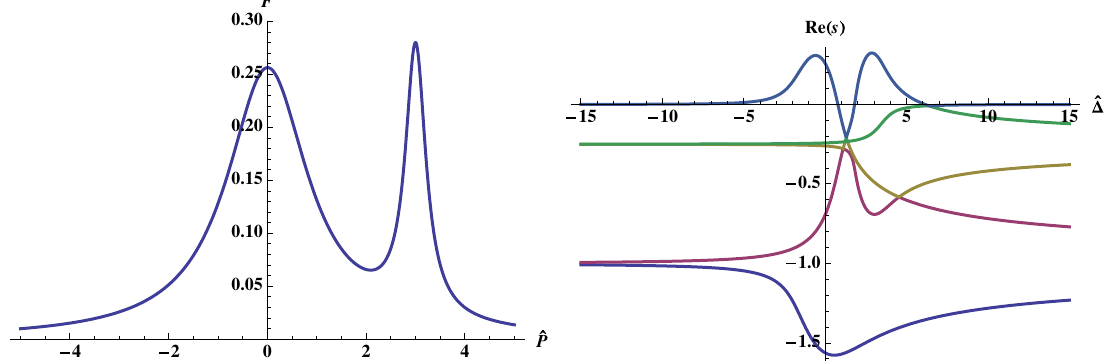
¼ 1 , (cid:9) ¼ 0 : 25 , (cid:8) ¼ 3 . (b) Real parts of five roots of the dispersion 1 2